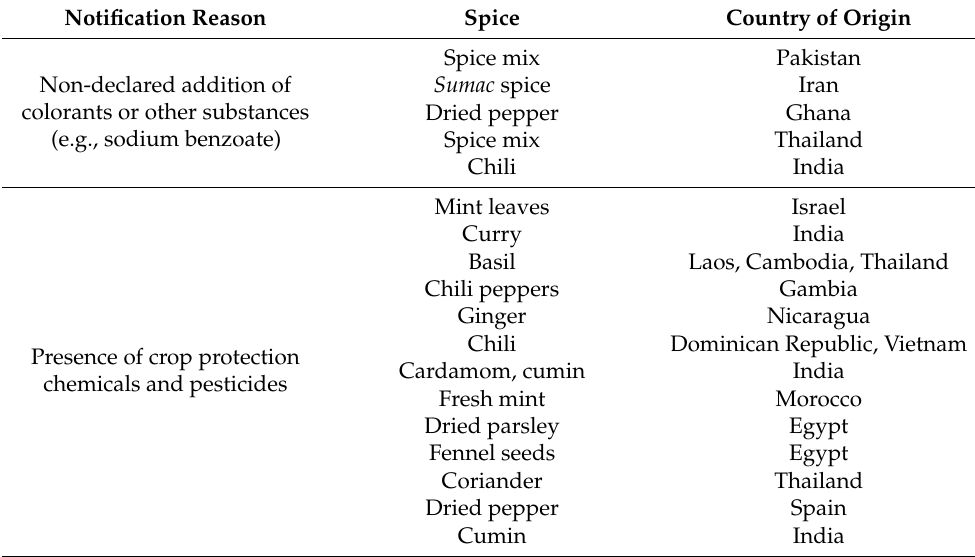
Table 3. Selected notifications due to the presence of undeclared additives, pesticides, and plant protection products in spices from different countries in 2015–2019 based on the RASFF-EC-Notifications